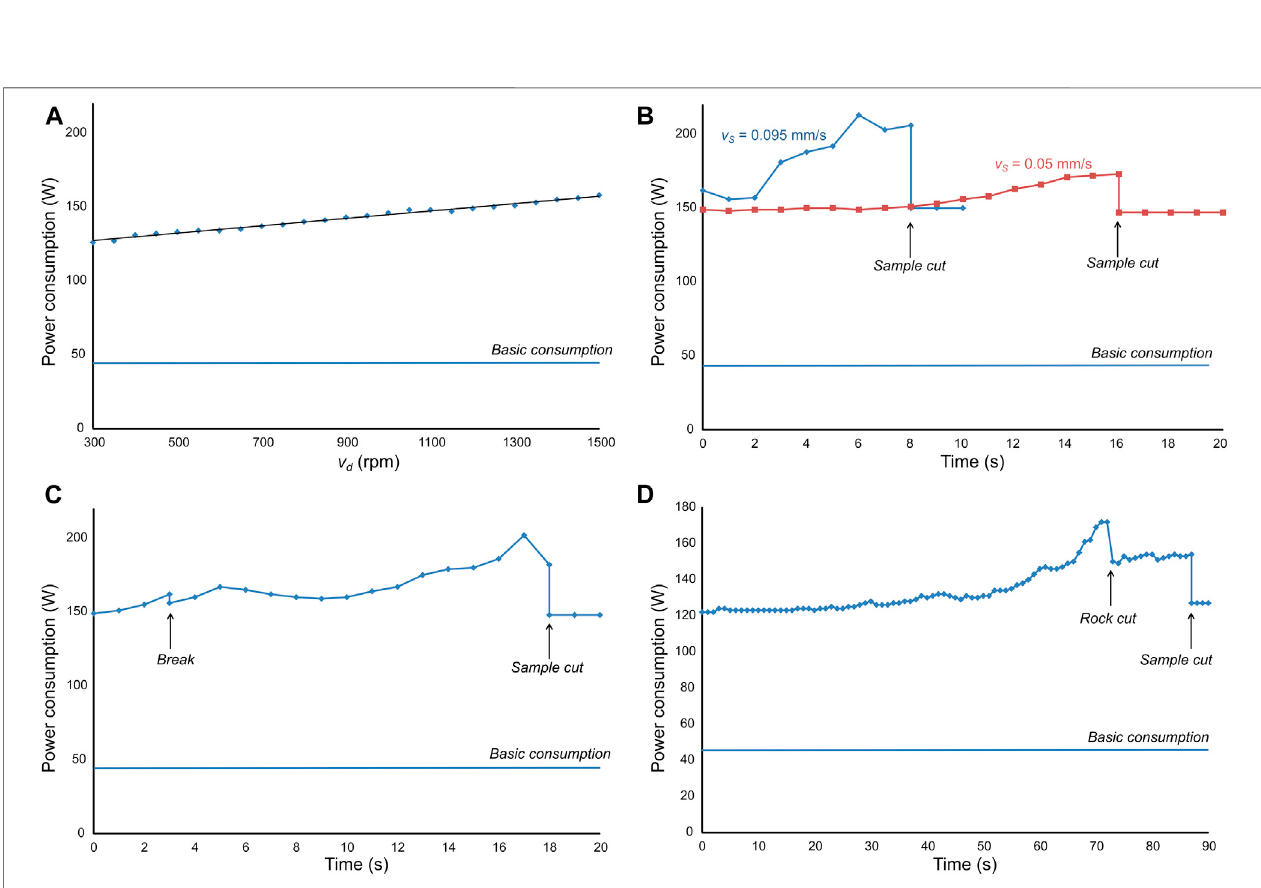
FIGURE 4 | (A) Power consumption of the Struers Secotom 10 disc saw versus disc rotation speed. (B – D) Power consumption versus time for various samples and parameters: (B) chertsample,wateron, v d (cid:2) 900 rpmand v s (cid:2) 0.095 mm s − 1 (in blue),and v d (cid:2) 900 rpm and v s (cid:2) 0.05 mm s − 1 (inred), (C) komatiite sample,water off, v d (cid:2) 900 rpm and v s (cid:2) 0.05 mm s − 1 , (D) basalt sample, water off, v d (cid:2) 300 rpm and v s (cid:2) 0.01 mm s − 1 .